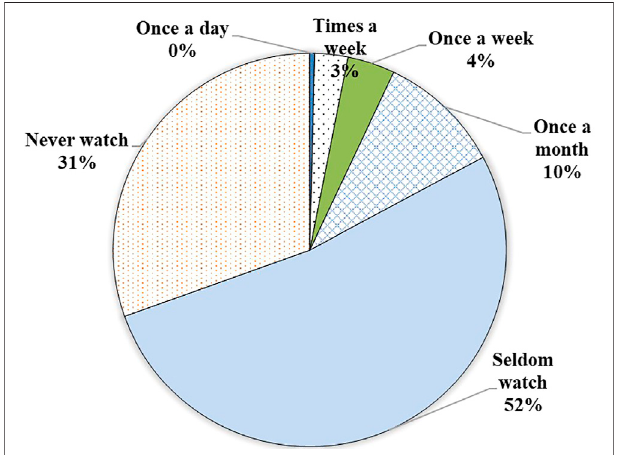
FIGURE 10 | Survey result of consumers ’ CEMS browsing behavior.